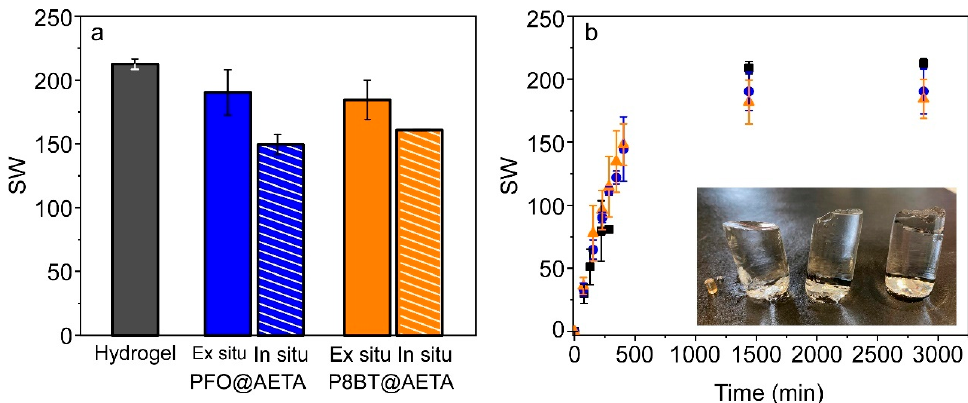
Figure 3. Maximum swelling degree of AETA hydrogel, PFO@AETA ex situ and situ, and F8BT@AETA ex situ and in situ ( a ). The corresponding swelling evolution of AETA hydrogel (black) and ex situ PFO@AETA (blue) and F8BT@AETA (orange) ( b ). Inset: Digital image of the dried hydrogel and the fully swollen hydrogel, ex situ PFO@AETA, and F8BT@AETA (from left to right). Error bars represent the standard deviation of three